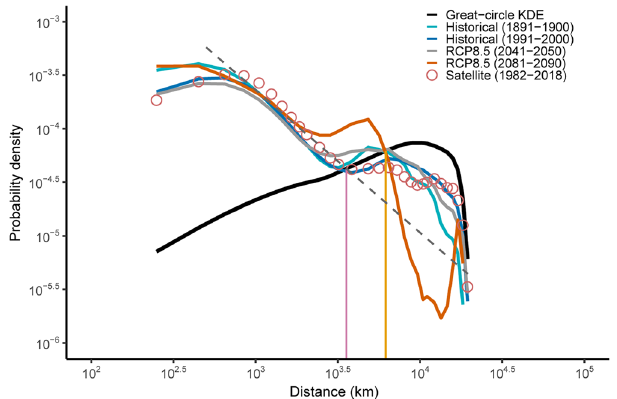
Figure 5. Distance distribution of MHW synchronization. Probability density function of spatial distances of significant event synchronization for different time windows within the historical and RCP8.5 scenarios and for the whole period of observed (satellite) data. The black line shows the kernel density estimates (KDE) of the distribution of all possible great-circle distances of MHWs. The dashed line is the power-law fit to the satellite distribution within the range of 500–3600 km (power-law exponent α = 1.33, R 2 = 0.96). A nearly identical power-law fit in the same spatial range is obtained for historical distributions in the period 1991–2000 (power-law exponent α = 1.32, R 2 = 0.97, fit not shown). The pink vertical line at about 3600 km marks a shift from regional to large-scale patterns of MHW synchronization for satellite and historical (1991–2000) distance distributions. The yellow vertical line shows extended spatial scales of synchronization at about 6000 km for the thick-tailed distributions of historical (1891–1900) and RCP 8.5 (both periods) distances. At distances below 400 km the distribution is biased by the resolution of grid cells (1° × 1°), with smaller geographical distances near the